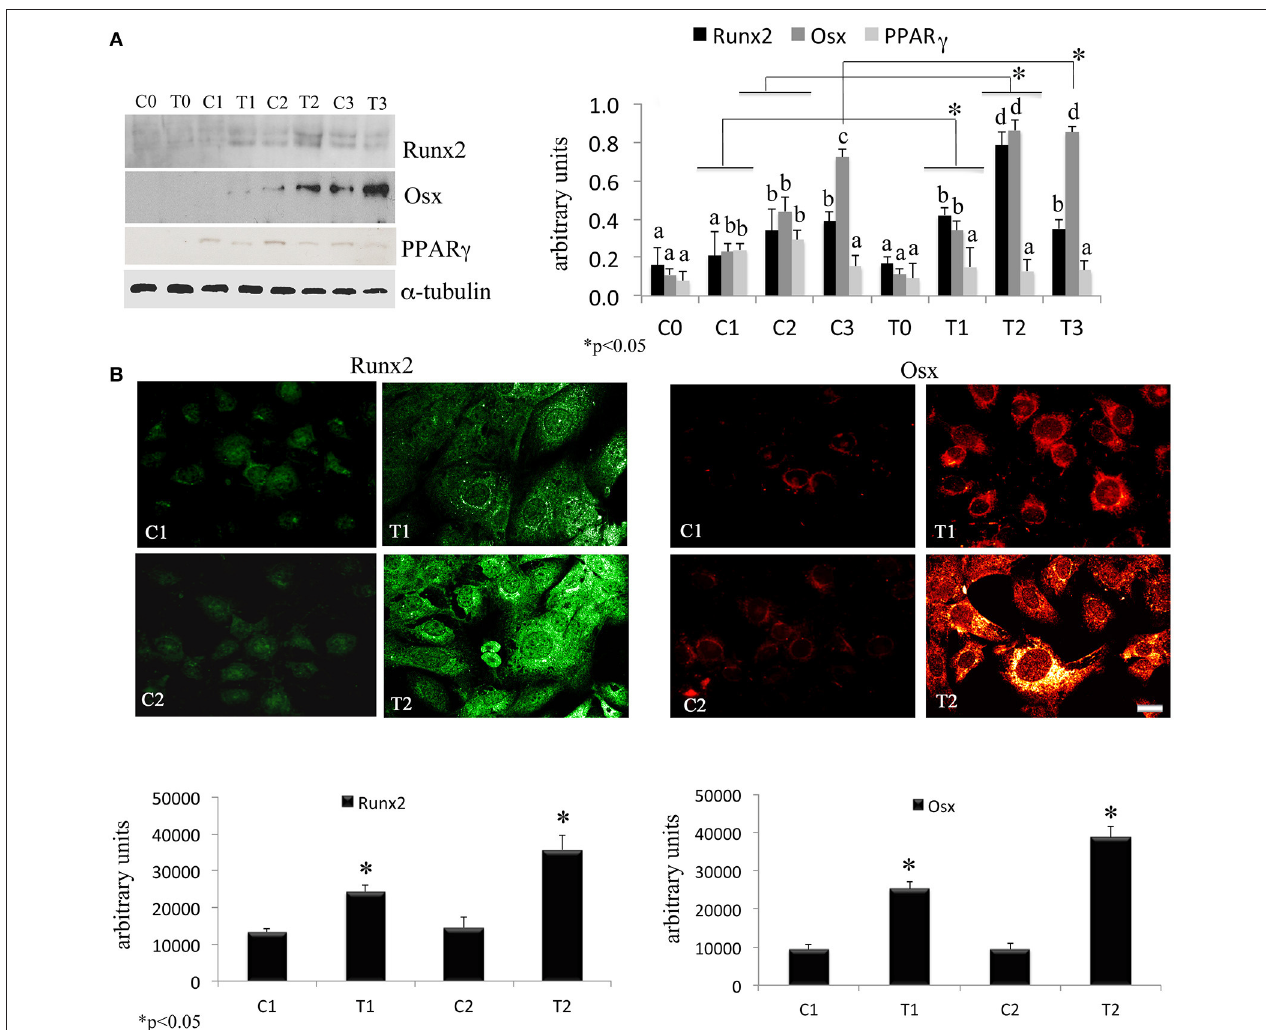
FIGURE 1 | (A) Time-course effects of laser irradiation on Runx2, osterix, and PPAR γ synthesis in BMSCs by western blotting analysis. Cells were laser irradiated over different period of time (Day 0: T0; 5 days: T1; 10 days: T2; 15 days: T3). Control cultures (Day 0: C0; 5 days: C1; 10 days: C2; 15 days: C3) were maintained in identical conditions except that the laser device was switched off. At the end of each treatment, proteins from BMSCs irradiated and untreated were extracted, subjected to SDS-PAGE, transferred to a PVDF membrane, and probed with rabbit anti-Runx2, rabbit anti-osterix, or rabbit anti-PPAR γ antibodies; filters were stripped and re-probed mouse anti- α -tubulin antibody to show equal amount of loading. Graphic represents results of three independent experiments. Data were analyzed by using one-way ANOVA. Lowercase letters denote homogeneous subsets. Error bars represent ± SE (* p < 0.05) (A) . The labeling pattern of Runx2 or osterix in BMSCs laser irradiated and untreated. Representative images of Runx2 or osterix localization using a rabbit anti-Runx2 antibody (green: Alexa Fluor 488 staining) and the rabbit anti-osterix antibody (red: Alexa Fluor 594 staining). Bar, 50 µ m. Fluorescence analysis from a pool of three different experiments was quantified by a Tecan Infinite fluorescence reader. The values that analyzed by Magellan v4.0 software are reported as means ± SD and statistically analyzed; * p < 0.05 (B) .